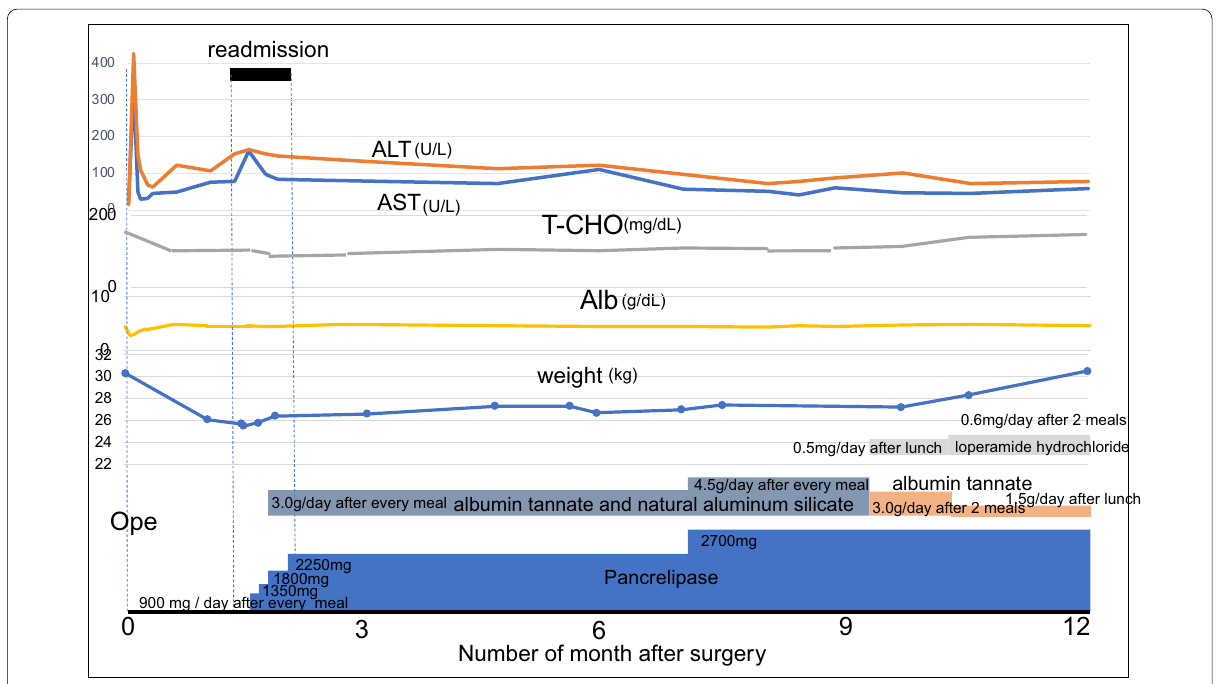
Fig. 4 Postoperative course. The postoperative course from immediately before surgery to the present is shown. The top row shows AST/ ALT levels, total cholesterol, albumin, and weight. The bottom row shows medications that are used. The AST/ALT levels are elevated again at readmission after recovery from acute postoperative elevation. It has progressively reduced with the diagnosis and initiation of treatment for NAFLD. The total cholesterol level decreased after the surgery, and after the lowest value of 94 mg/dL at the time of readmission. It was restored to the normal range one year after the surgery following the diagnosis of NAFLD and initiation of treatment. Albumin levels remain unchanged, except for in the acute postoperative period. The patient’s weight is 30.3 kg immediately preoperatively, but decreased to 25.4 kg on readmission. Subsequently, with the diagnosis of NAFLD and initiation of treatment, she recovered to her preoperative weight. ALT alanine aminotransferase, NAFLD nonalcoholic fatty liver disease, AST aspartate aminotransferase